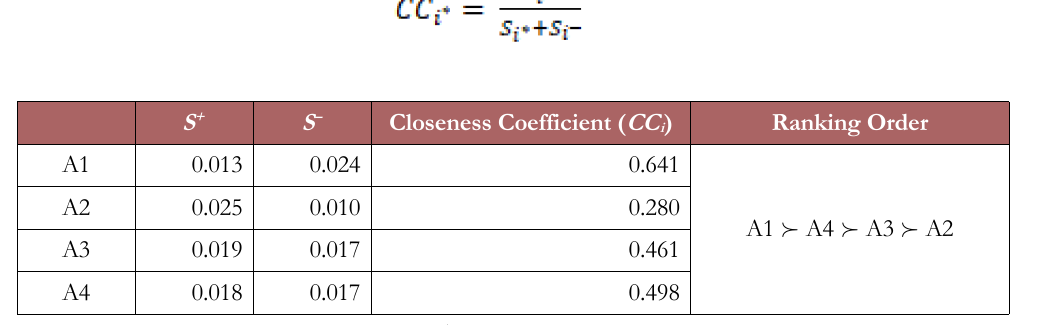
Table 19. The distances toward FPIS ( S + ) and FNIS ( S – ) as well as Closeness Coefficient ( CC